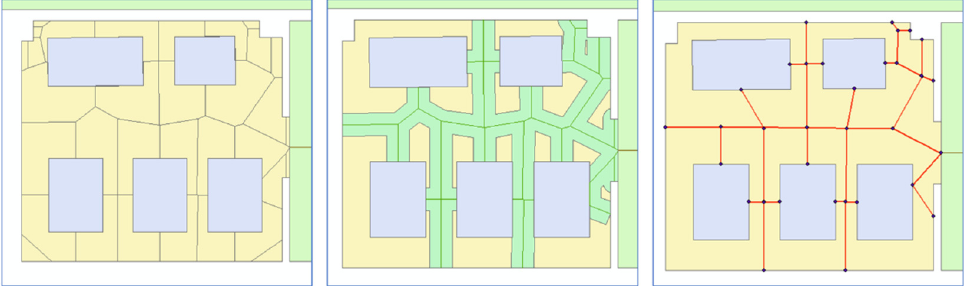
Figure 18. Generating a Level 4 network for a room using Z-buffering.